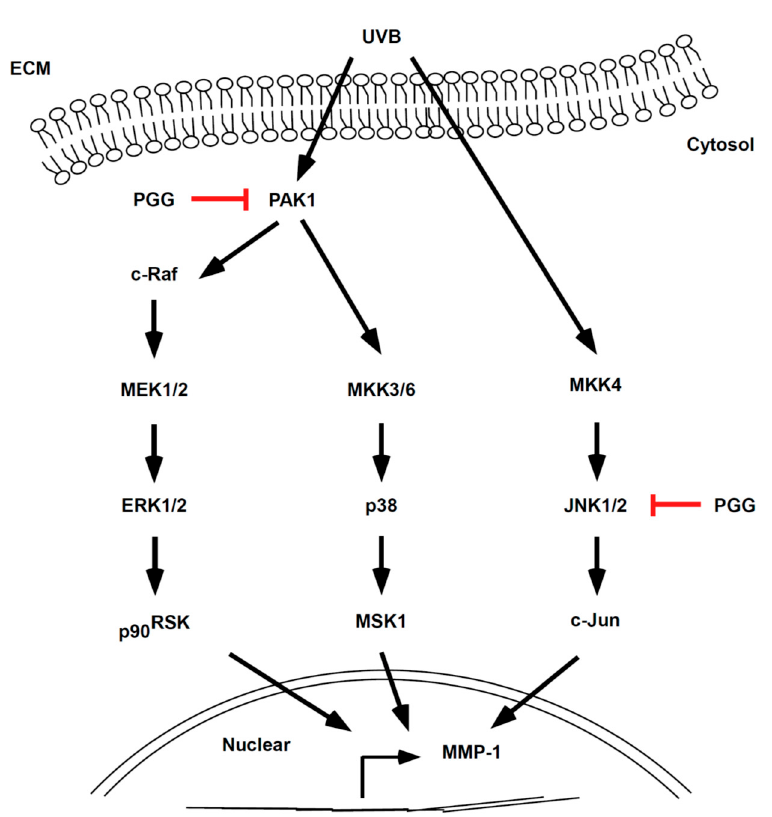
Figure 7. Simplified depiction of the proposed anti-photoaging mechanism of PGG.